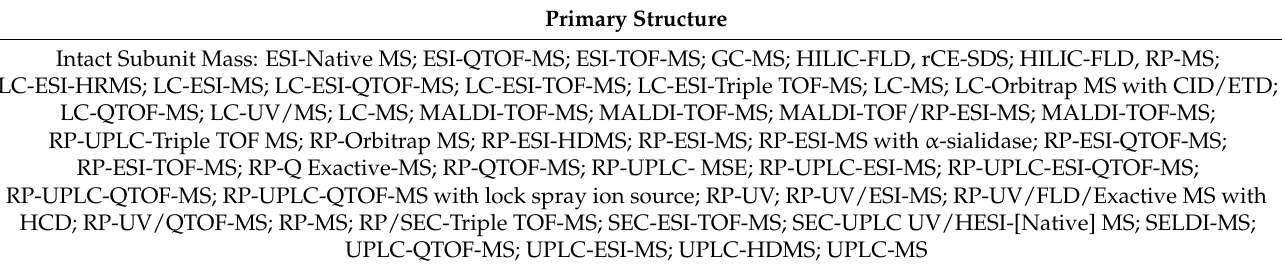
Table 2. Advanced analytical methods used in the analytical assessment of